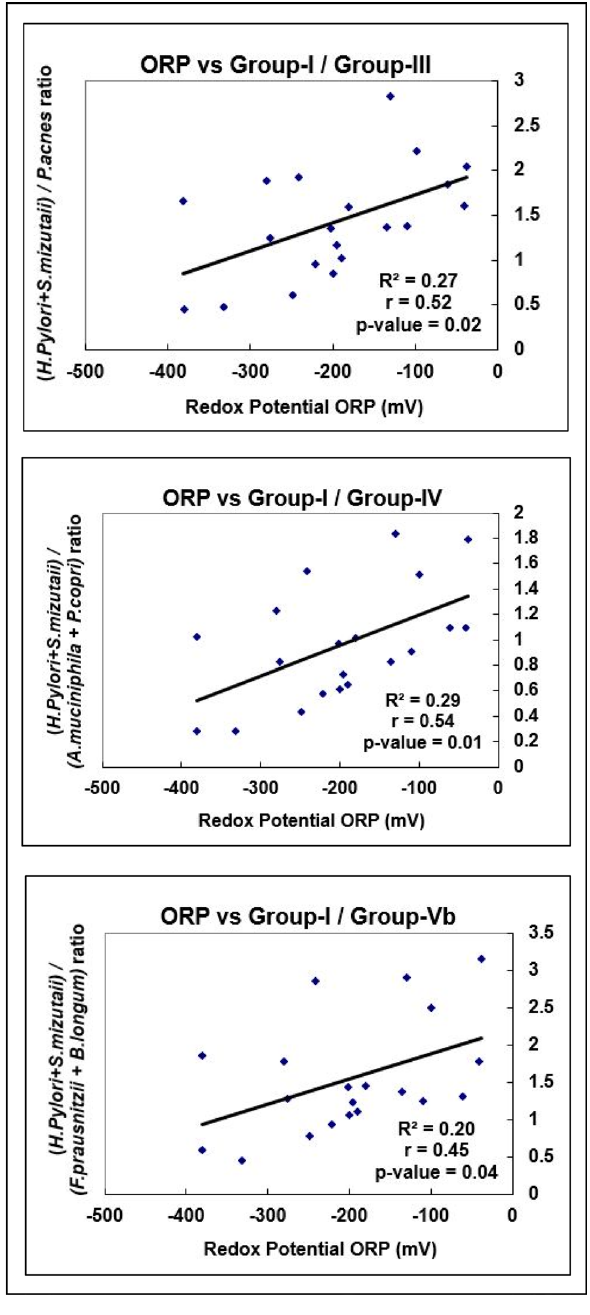
Figure 1. Linear regression analysis of Microbial Redox Index with tissue